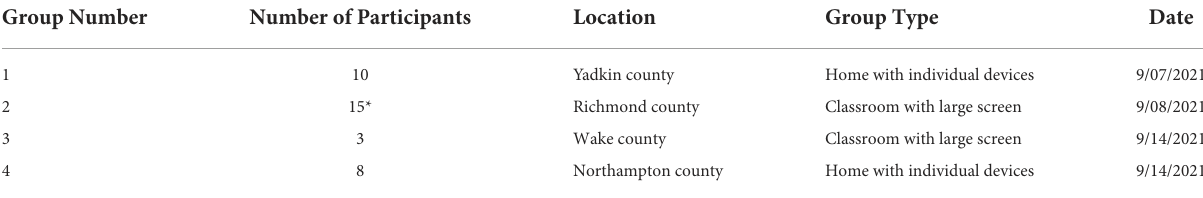
TABLE 1 Workshop participants, locations, and